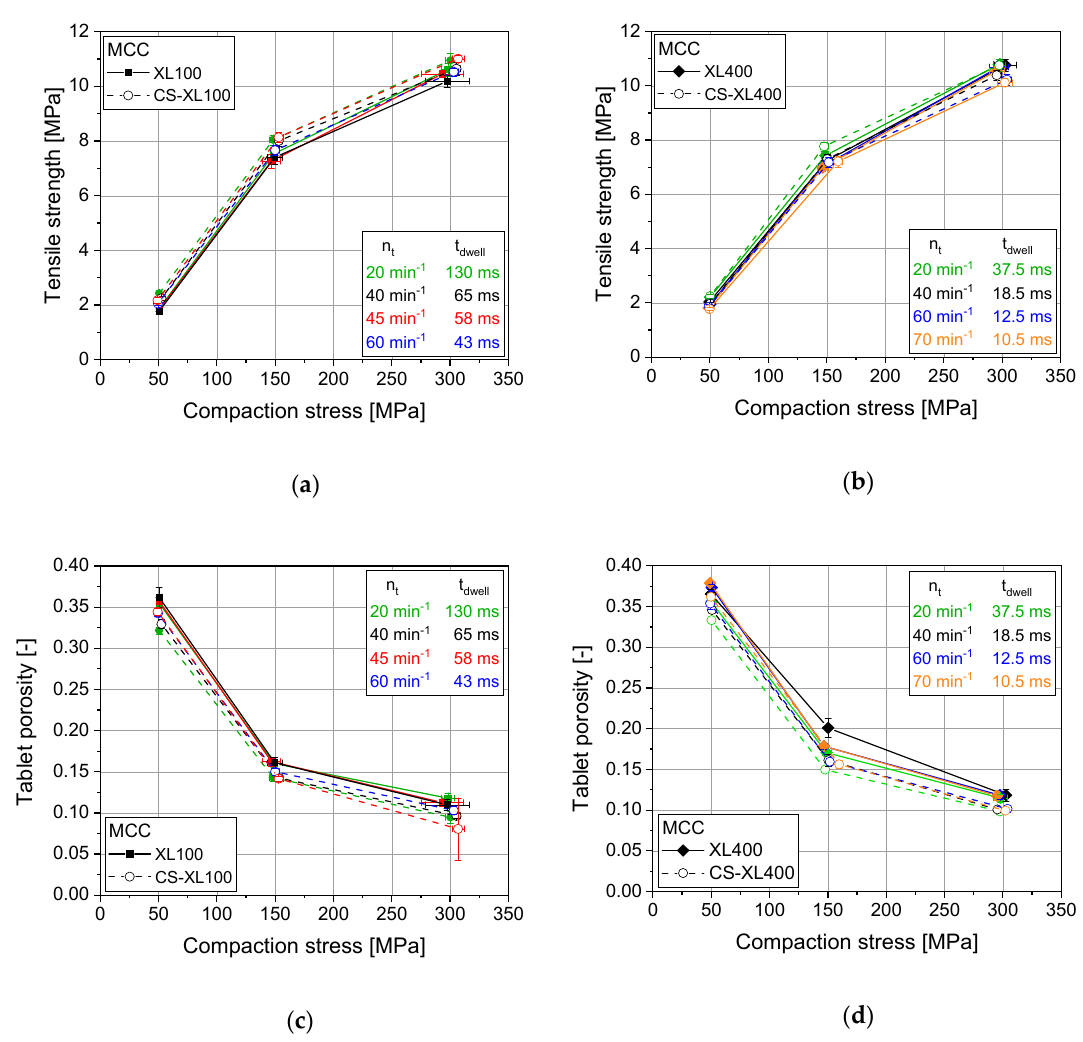
Figure 1. Tabletability profile for Microcrystalline cellulose on XL100 ( a ) and XL400 ( b ) and porosity as a function of compaction stress on XL100 ( c ) and XL400 ( d ) as well as for their simulated profiles (CS) applying 14 mm punches, respectively. n = 10 .